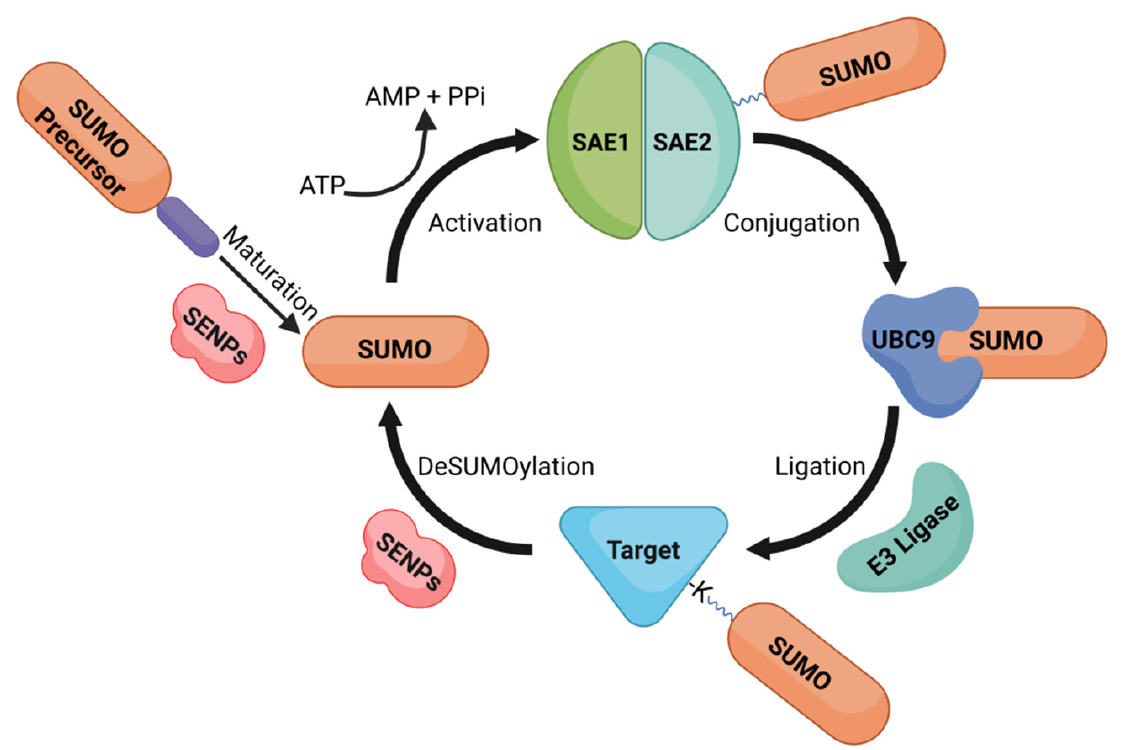
Figure 1. The catalytic cycle of SUMOylation and deSUMOylation. Maturation: SENPs process the SUMO precursor into mature SUMO. Activation: SUMO is activated in an ATP-dependent 2-step reaction by the heterodimeric E1 enzyme and bound via a thioester bond on cysteine residues to the